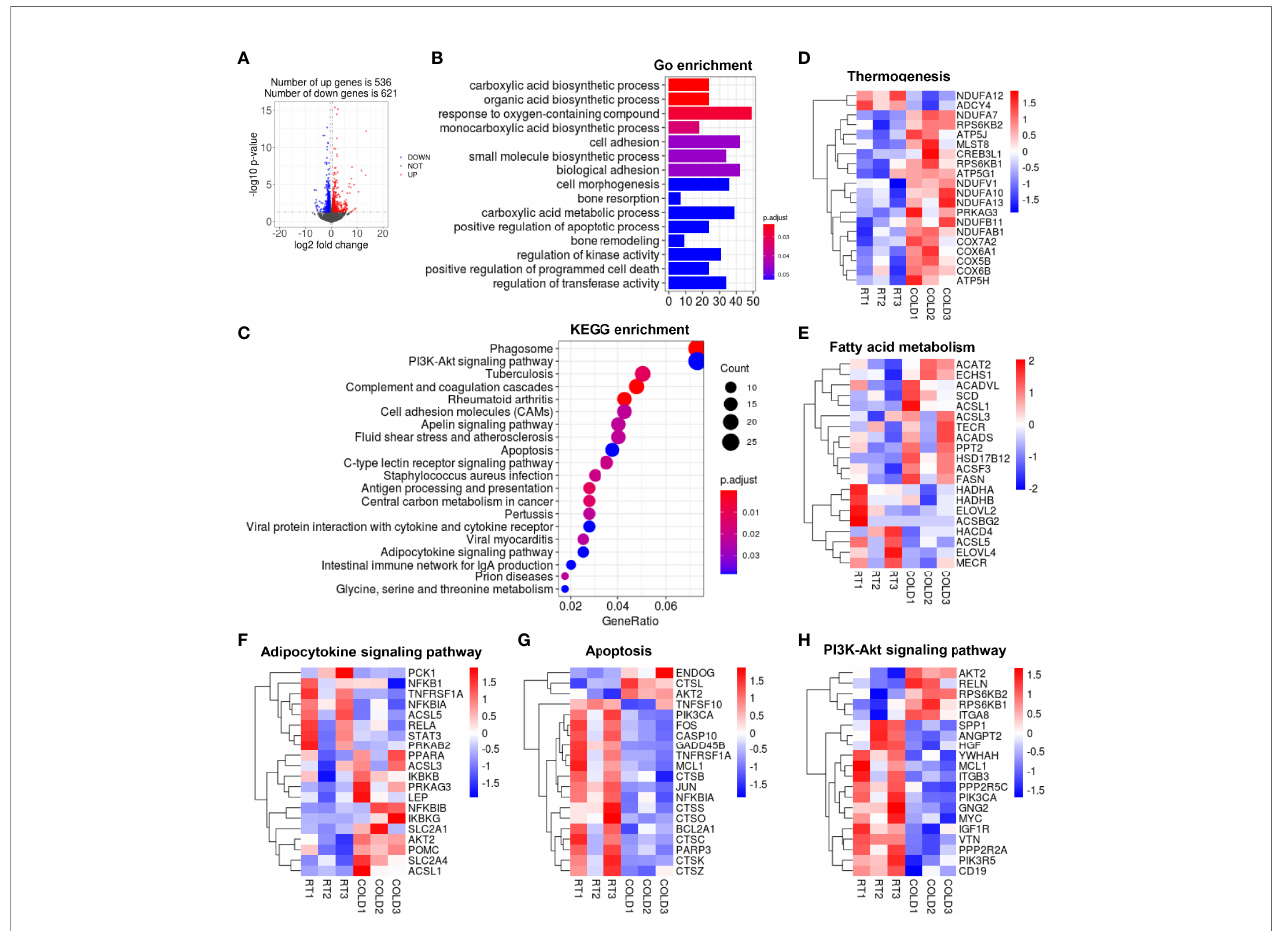
FIGURE 3 | The changes of transcriptome pro fi le in porcine SAT after cold exposure. (A) Volcano plot of differently expressed genes (DEGs). Log2 fold changes in exons of RNA-seq gene bodies in COLD versus RT pigs and the corresponding signi fi cance values displayed as log10 (P value). In total, 536 and 621 genes were identi fi ed that had induced (red) or repressed (blue) expression levels by cold exposure, gray denotes genes with no signi fi cant changes. (B) Gene Ontology (GO) enrichment analysis. (C) Functional enrichment analyses using Kyoto Encyclopedia of Genes and Genomes (KEGG) pathways. (D, E) Heatmaps of the TPM expression values of selected thermogenesis, fatty acid metabolism regulated genes from the RNA-seq dataset. (F – H) KEGG results of the cold-induced enrichment of genes involved in adipocytokine signaling pathway (F) , apoptosis (G) , PI3K-Akt signaling pathway (H)